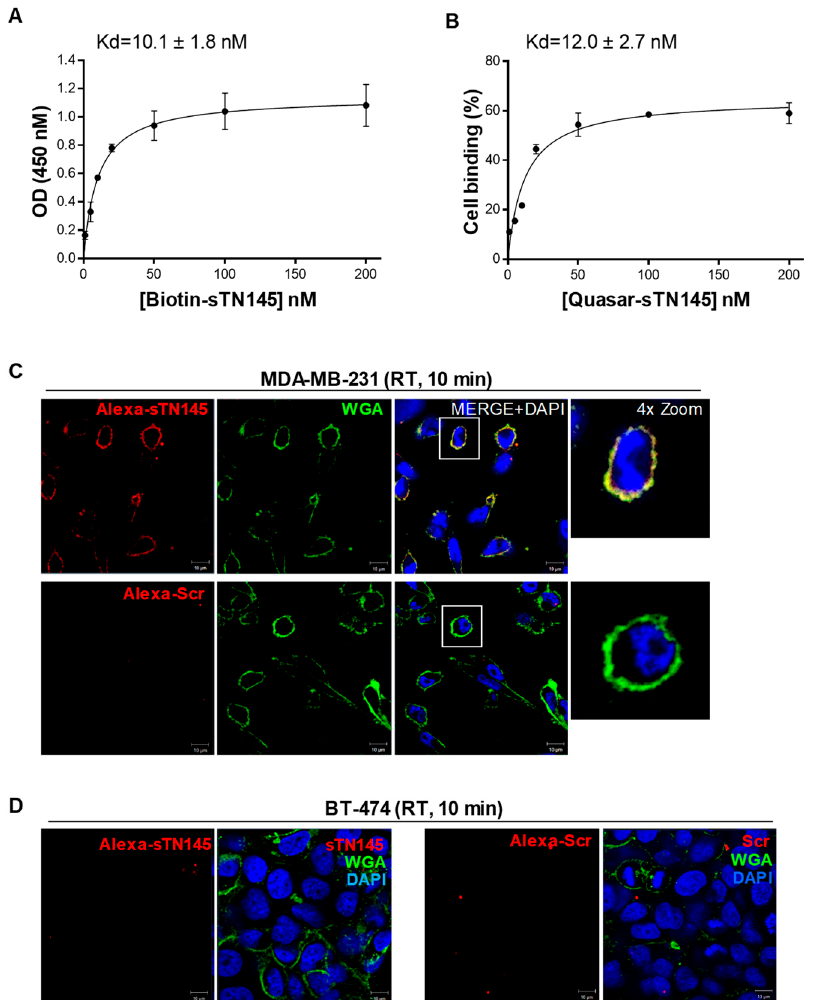
Figure 2. Cell binding of the sTN145 aptamer. Binding curves of sTN145, 5 ′ -biotinylated ( A ) or 5 ′ -Quasar 670-labeled ( B ) on MDA-MB-231 cells for calculation of the apparent Kd of aptamer-cell interaction. Binding was analyzed using streptavidin-biotin-based ( A ) or flow cytometric ( B ) assays. Data shown are mean ± SD of three independent experiments. ( C , D ) Representative confocal images of MDA-MB-231 ( C ) and BT-474 ( D ) cells incubated for 10 min at RT with Alexa 647-labeled sTN145 or Scr. After washing and fixation, cells were labeled with WGA-488 (green) to visualize the cell membrane and with DAPI (blue) to stain nuclei. Alexa 647-labeled aptamers are displayed in red. All digital images were captured at the same setting to allow direct comparison of staining patterns. Magnification 63 × , 1.0 × digital zoom, scale bar = 10 µ m. At least three independent experiments were performed. In ( C ), co-localization results appear yellow in the merged images. Inset: 4 × digital